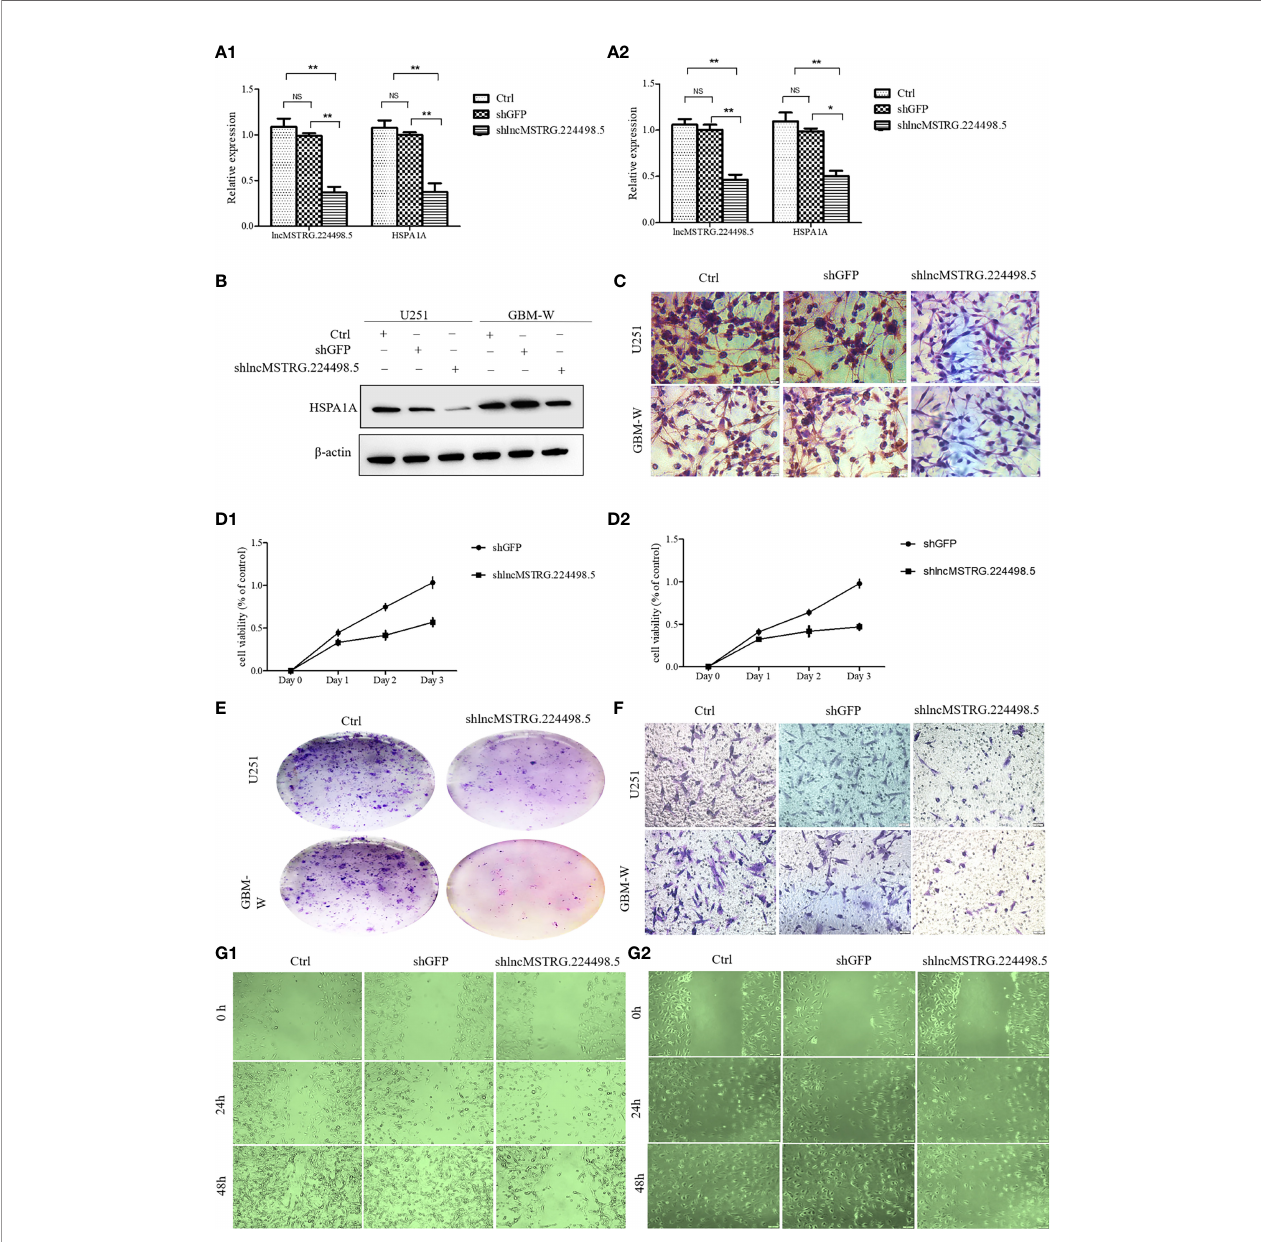
FIGURE 4 | LncRNAs NONHSAT079852.2 can promote the proliferation, invasion and migration of glioma cells. (A) qRT-PCR analysis of HSPA1A in U251(A1) or GBM-W(A2) cells after transfection for 48 hours. (B) Western blot analysis of HSPA1A in U251 or GBM-W cells after transfection for 48 hours. (C) IHC analysis of HSPA1A in U251 or GBM-W cells after transfection for 48 hours. (D) Growth curve of U251(D1) or GBM-W (D2) cells after transfection for 48 hours by CCK8 assay. (E) Proliferation of U251 or GBM-W cells after transfection for two weeks as determined by colony-formation assay. (F) Migration and invasion ability of U251 or GBM-W cells after transfection for 48 hours. (G) Migration of U251(G1) or GBM-W(G2) cells after transfection for 48 hours as detected by wound healing assay. Results were presented as mean ± SD. * p < 0.05, ** p < 0.01, NS, not signi fi